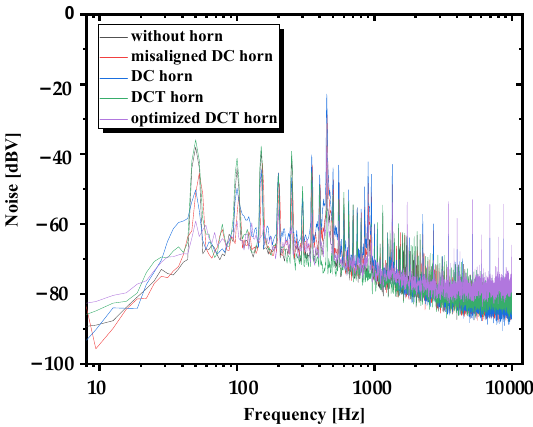
Figure 15. Noise of TAPVS with and without acoustic horns.